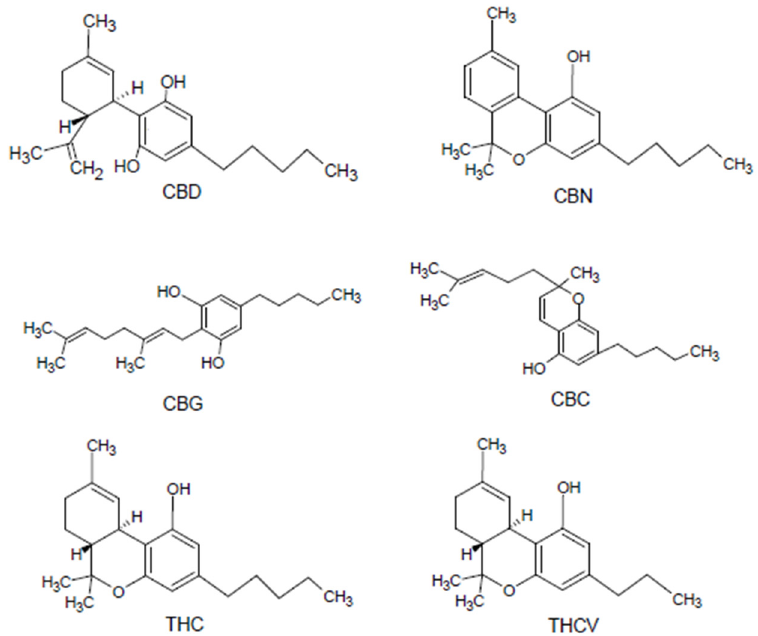
Figure 2. Structural formulas of cannabinoids occurring in hemp (CBD—cannabidiol; CBN—canna- binol; CBG—cannabigerol; CBC—cannabichromene; THC—tetrahydrocannabinol; THCV—tetra-